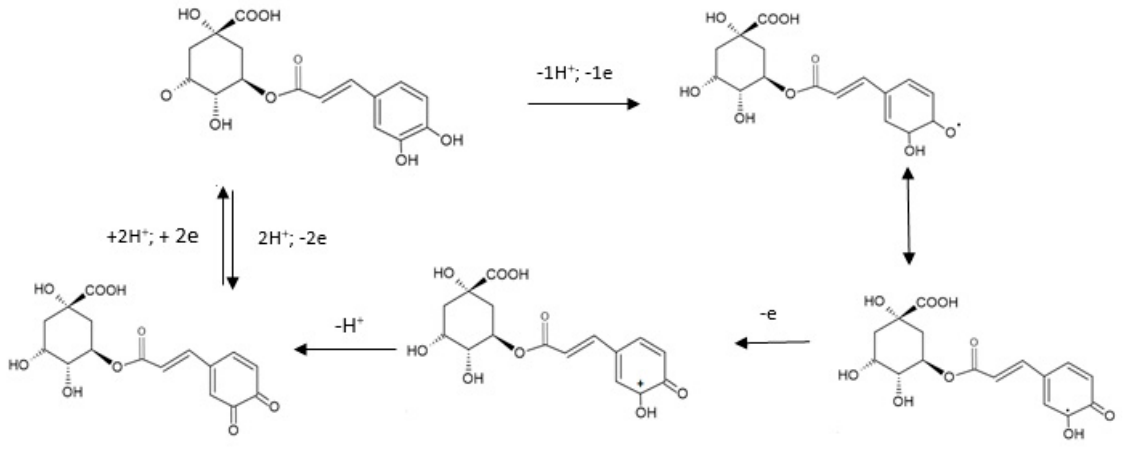
Figure 5. The oxidation mechanism of CGA.